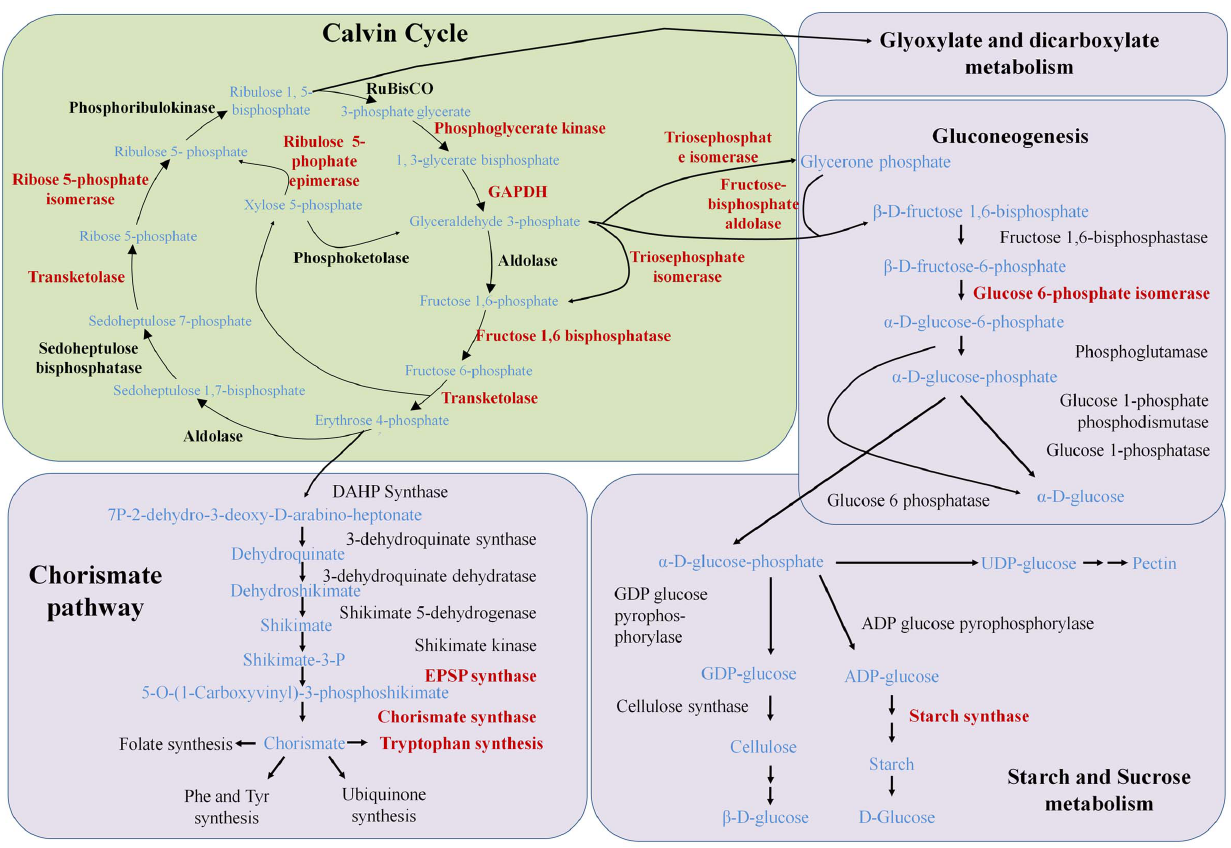
Figure 1. Calvin-Benson cycle and associated pathways. The genes found in Pfiesteria piscicida EST database were marked in red color.